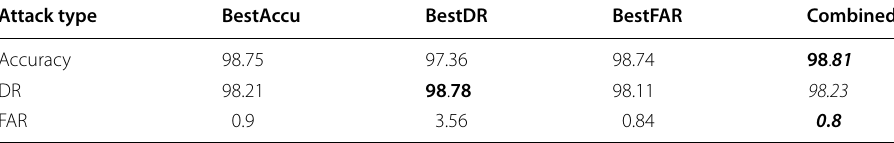
Table 8 Comparison of overall accuracy, detection rate and false alarm rate of combined solutions Attack